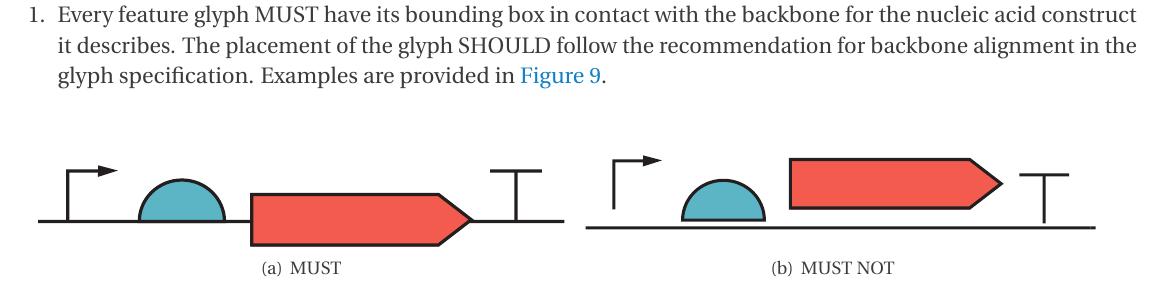
Figure 9: Examples of correct and incorrect association of glyphs with a nucleic acid backbone.